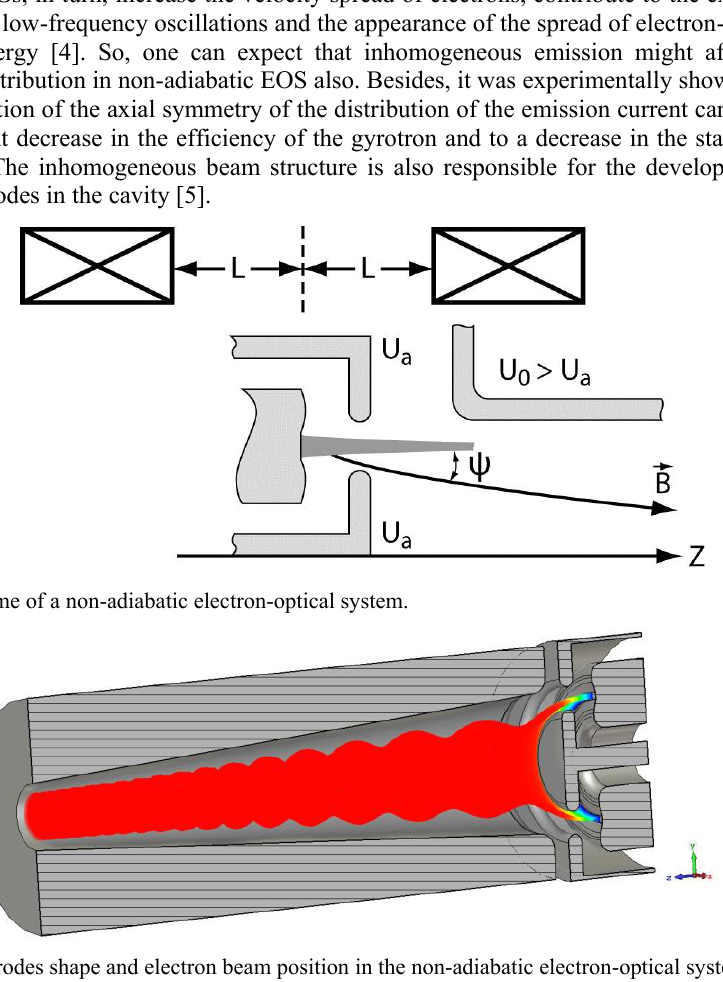
Fig. 2. Electrodes shape and electron beam position in the non-adiabatic electron-optical